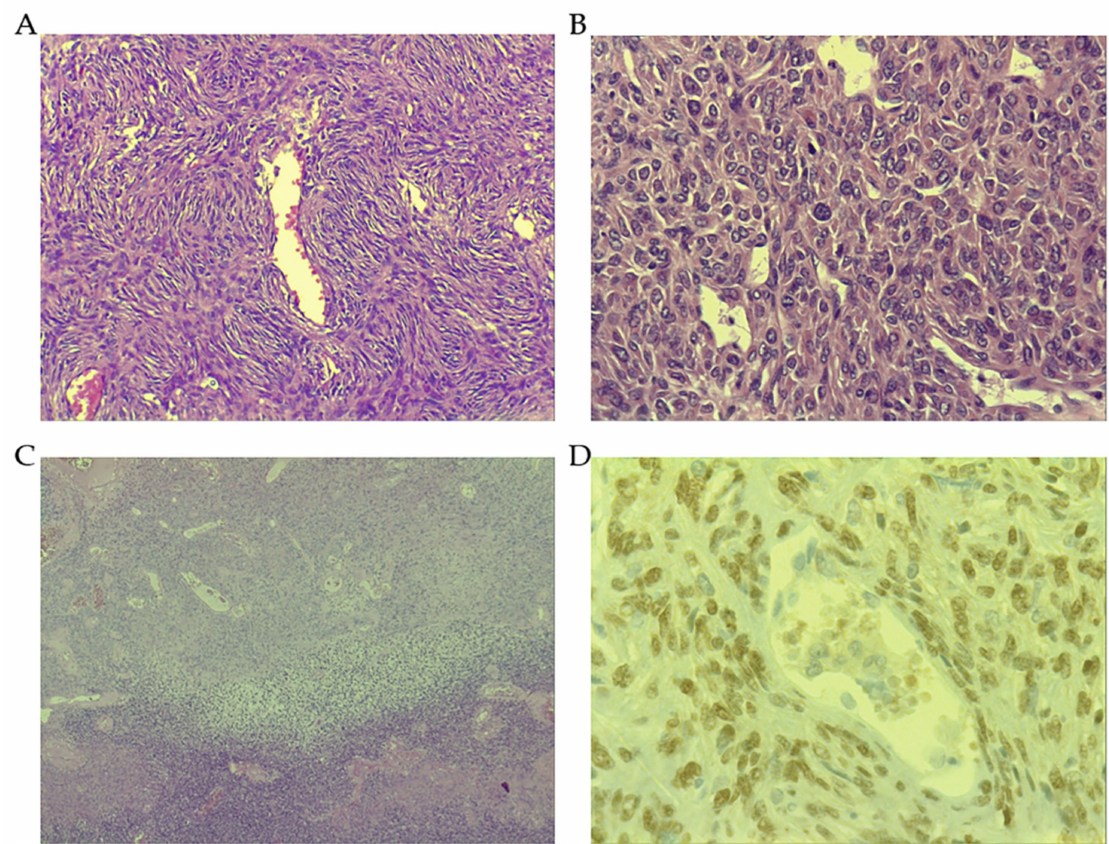
Figure 1. Histopathological features of solitary fibrous tumor (SFT). ( A ) Low-grade SFT showing a patternless pattern, with spindle cells, low number of mitosis (or lack of) and vessels with “staghorn” appearance (Magnification 40 × ). ( B ) High-grade SFT showing hypercellularity with nuclear pleomorphism, high number of mitotic figures (Magnification 200 × ). ( C ) Dedifferentiated SFT with an abrupt transition from conventional SFT to high-grade sarcoma (Magnification 10 × ). ( D ) STAT6 positive nuclear immunostaining (Magnification 400 ×